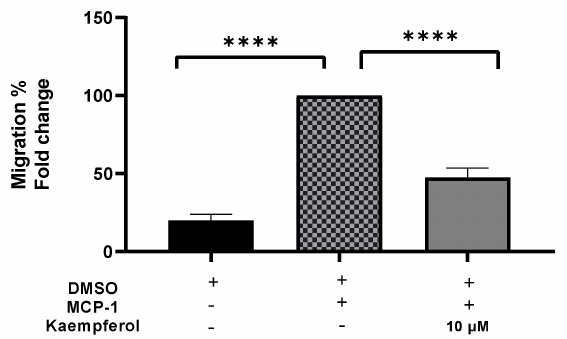
Figure 3. Kaempferol effectively inhibits THP1 monocyte migration triggered by MCP-1. The number of migrated cells was quantified and reported as a proportion of transmigrated cells to measure monocyte migration. The mean standard deviation of three separate experiments is reported. Statistical significance was determined by one-way ANOVA, with **** p ≤